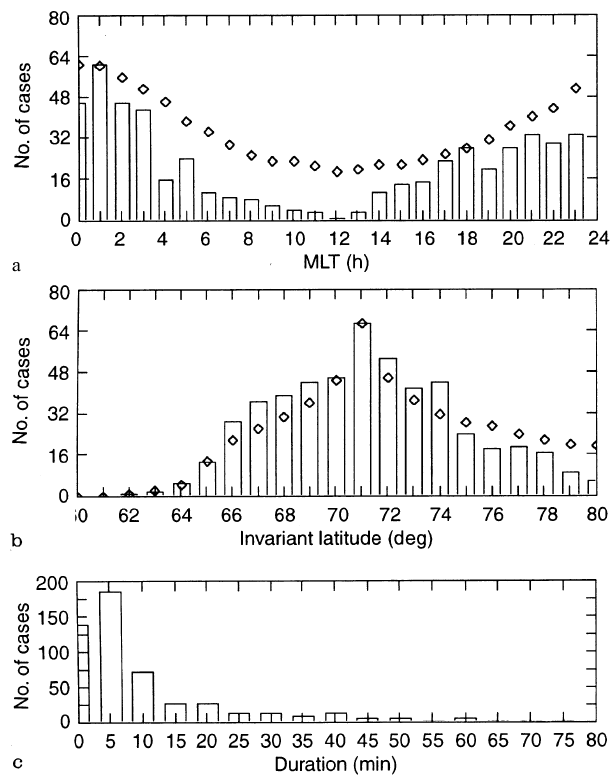
Fig. 3a–c. Statistics of 515 cases of UFCs recorded by POLRAD from September 4, 1996 to October 8, 1997. The selected cases are not shorter than 1 minute. a Distribution of spacecraft positions in MLT hours at times of UFC observations. b Distribution of spacecraft positions in invariant latitude at times of UFC observations. c Frequency of occurrence of UFC durations. On a and b values proportional to the integrated times of one year POLRAD operation are superposed (